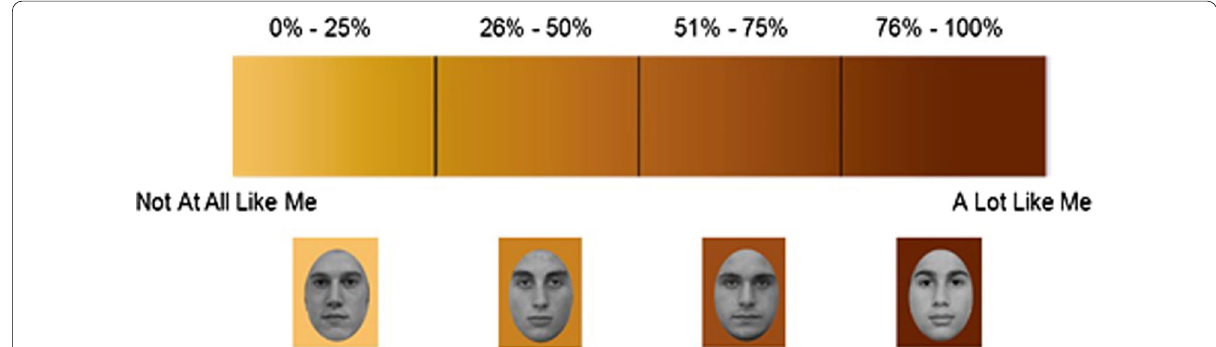
Fig. 1 Example of the color gradient used in the instructions in Experiments 1 and 2 to manipulate perceptions of similarity between targets and participants. In the Pilot Study, the same target stimuli were presented but with no gradient or similarity